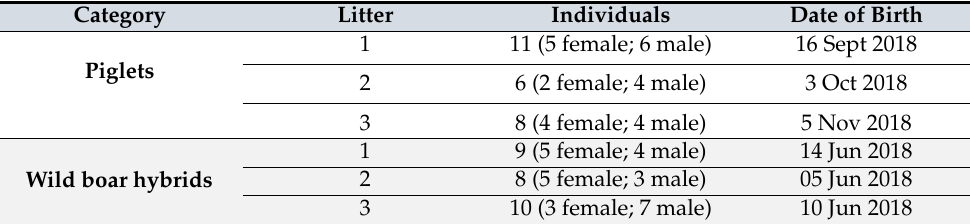
Table 1. Composition of the litters of piglets and wild boar